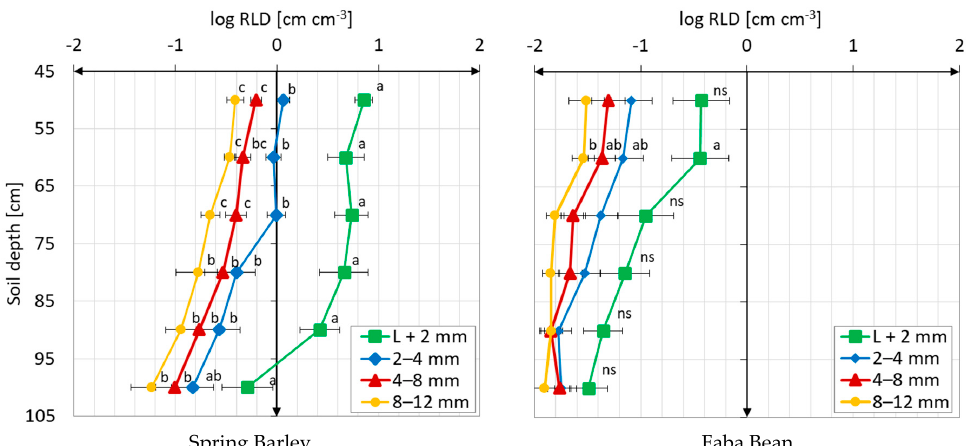
Figure 2. Log10-transformed RLD (cm cm − 3 ) of spring barley and faba bean. Mean and SE of lumen + 2 mm (L + 2) and the distances from macropore in different depth intervals. Means not sharing a common letter show significant differences between the distances from macropore within one depth interval (Tukey honestly significant difference (HSD), α = 0.05); ns = not significant. In both species, the highest share of roots (Table 2) was found in diameter class fine (0–0.2 mm) and small (0.2–0.4 mm). In spring barley, there was a clear difference between the share of roots in